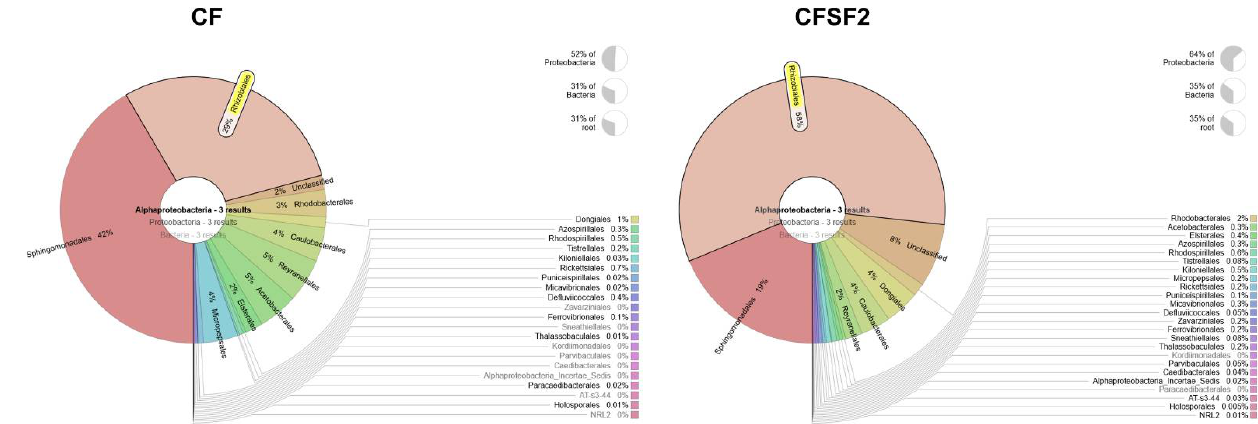
Figure 5. Krona plot showing the analysis results of Rhizobiales in CF and CFSF2. Circles from inside to outside stand for different taxonomic ranks, and the area of the sector shows the respective proportion of different OUT annotation